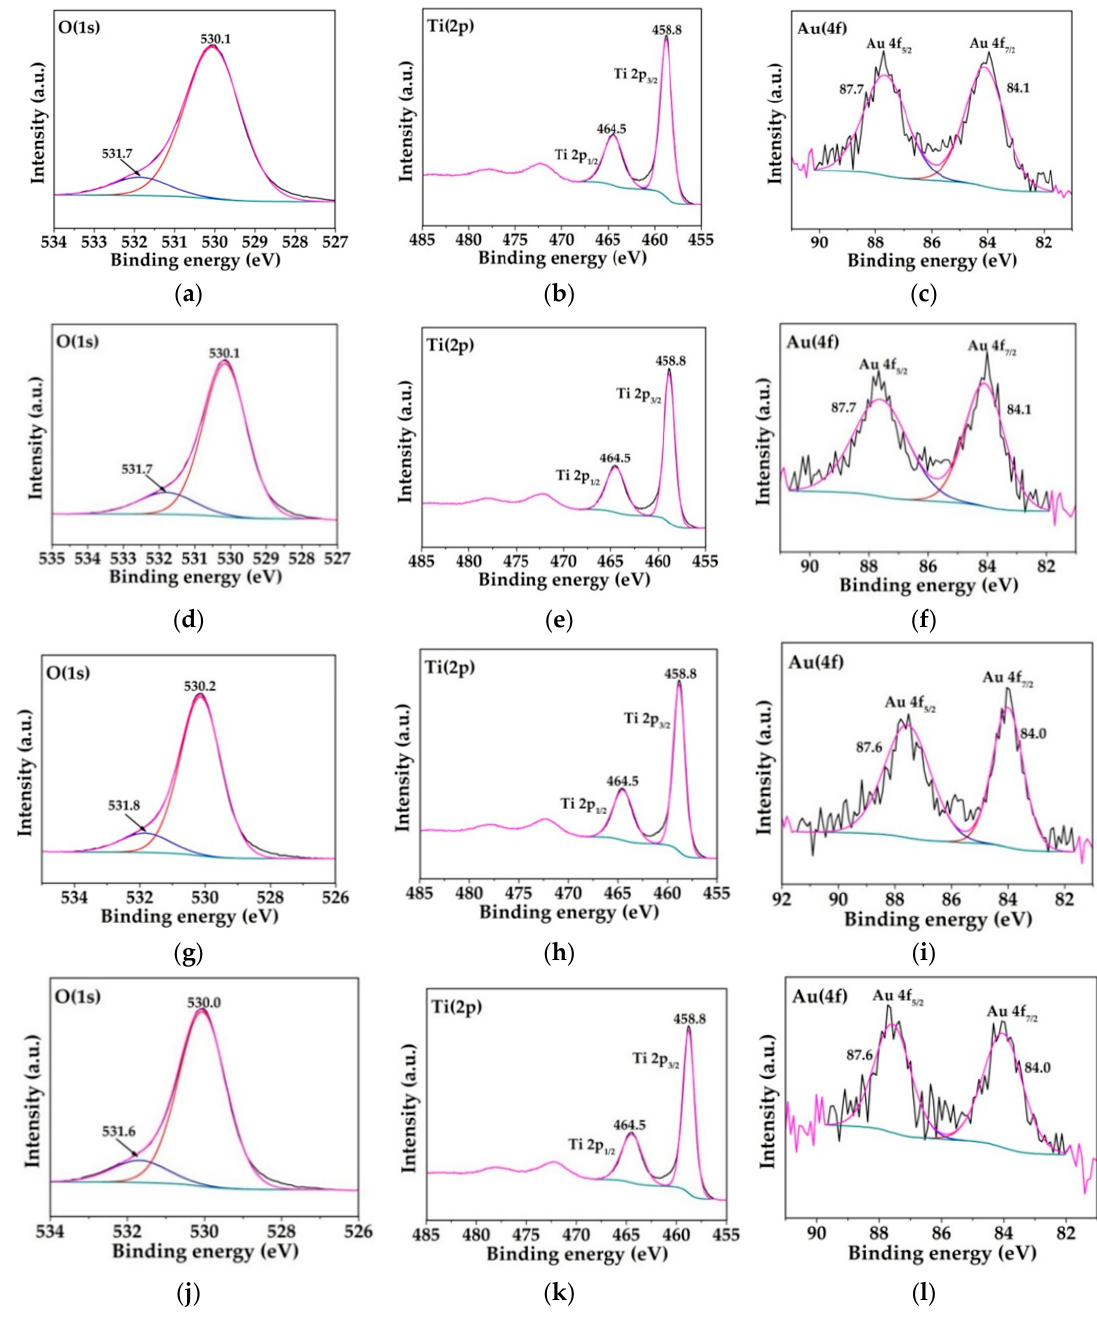
Figure 3. (A – C ) 5Au-120; ( D – F ) 5Au-15; ( G – I ) 2Au-120; ( J – L ) 2Au-15. Figure 3. ( a – c ) 5Au-120; ( d – f ) 5Au-15; ( g – i ) 2Au-120; ( j – l )